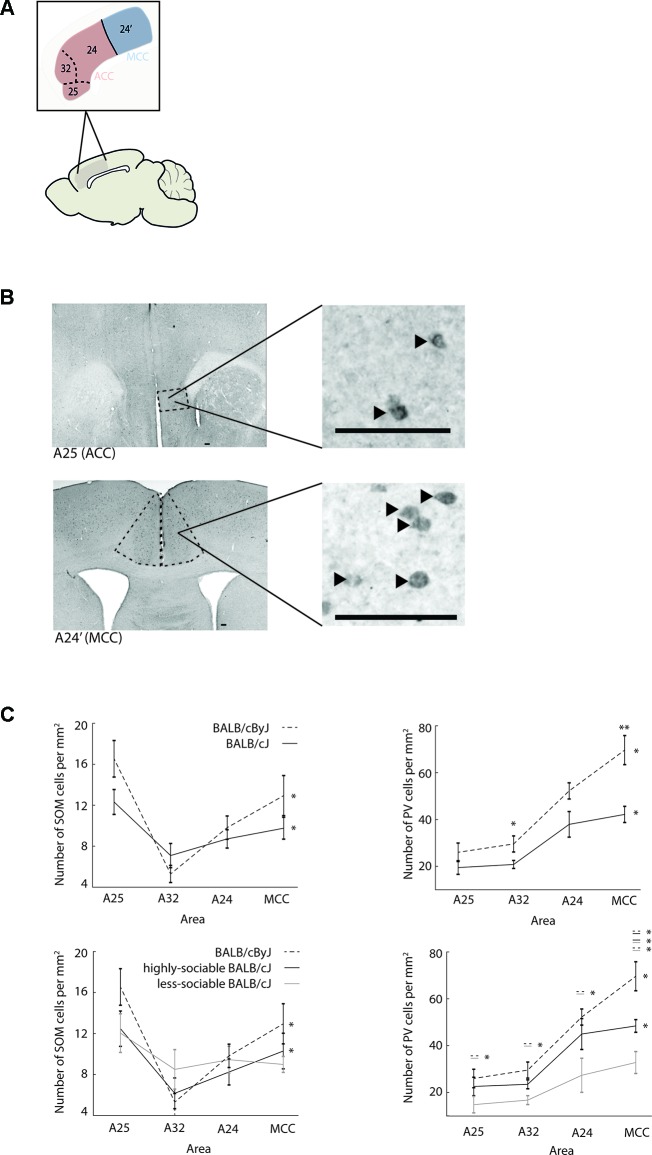
Interneuron populations across anterior cingulate cortex (ACC) and midcingulate cortex (MCC) (A) Schematic showing the definition of ACC and MCC used in this study. ACC consists of sub-areas A25, A32, and A24. MCC is not divided into sub-areas in the rodent and consists of area A24′ only. Note: the definition used here is homologous to the definition used in higher mammalian species and does not correspond to the cingulate area 1 vs. cingulate area 2 definition. (B) First row: macrographs of somatostatin (SOM) interneurons in A25 of ACC (dashed lines), zoom-in shows higher magnification macrograph of SOM interneurons in A25. Scale bar is 100 µm. Black arrow heads point to stained neurons. Second row: same for parvalbumin (PV) neurons in MCC. (C) First row: distribution of SOM and PV interneurons across ACC and MCC. Left panel: number of SOM interneurons per mm2 in A25, A32, and A24 of ACC and in MCC. Black line: BALB/cJ mice. Black dashed line: BALB/cByJ mice. Error bars: standard error of the mean (SEM). Right panel: same for PV population. Second row: same as first row but plotted separately for sociable (black line) and less-sociable BALB/cJ mice (gray line). *p < .05; **p < .01.